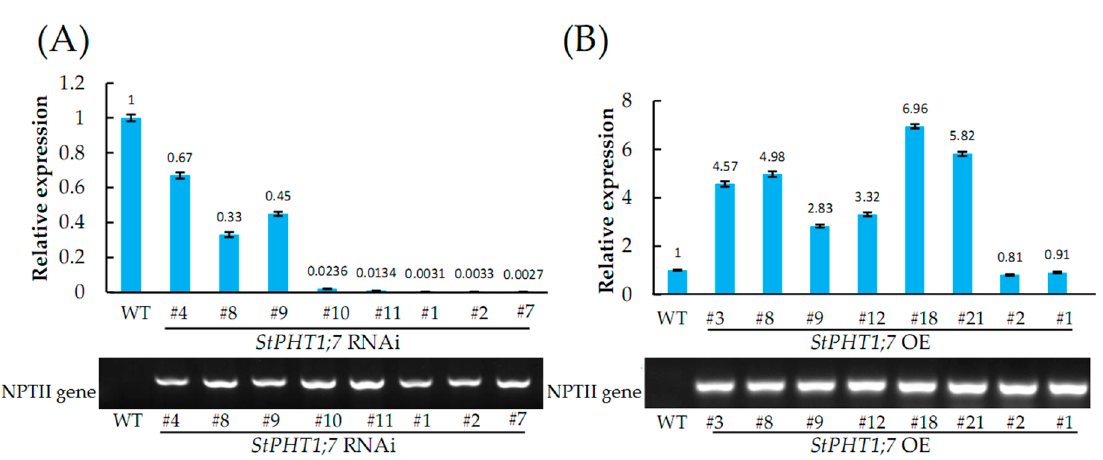
Figure 7. PCR and qRT-PCR analysis of StPHT1;7 silenced (RNAi) ( A ) and overexpressed (OE) ( B ) plants. Upper: relative expression of StPHT1;7 ; bottom: identification of NPTII . Each value is expressed as mean ± SD ( n = 9,3 biological repeats × 3 technical repeats). PCR and qRT-PCR samples were taken from the corresponding in vitro potato plantlets cultured for 30 days.